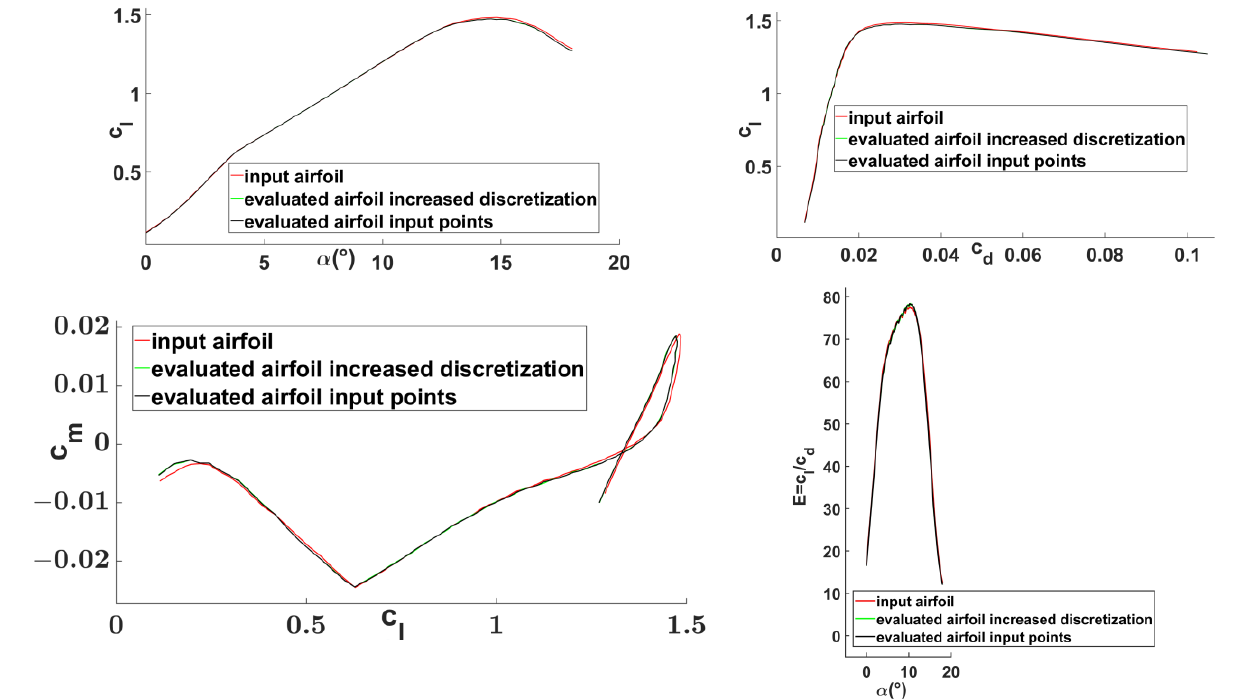
Figure 22. NACA 23012 input airfoil, evaluated airfoil, evaluated airfoil increased discretization (140 points) c l ( α ) , c l ( c d ) c m ( c l ) , E ( α ) = c l ( α ) / c d ( α ) comparison.